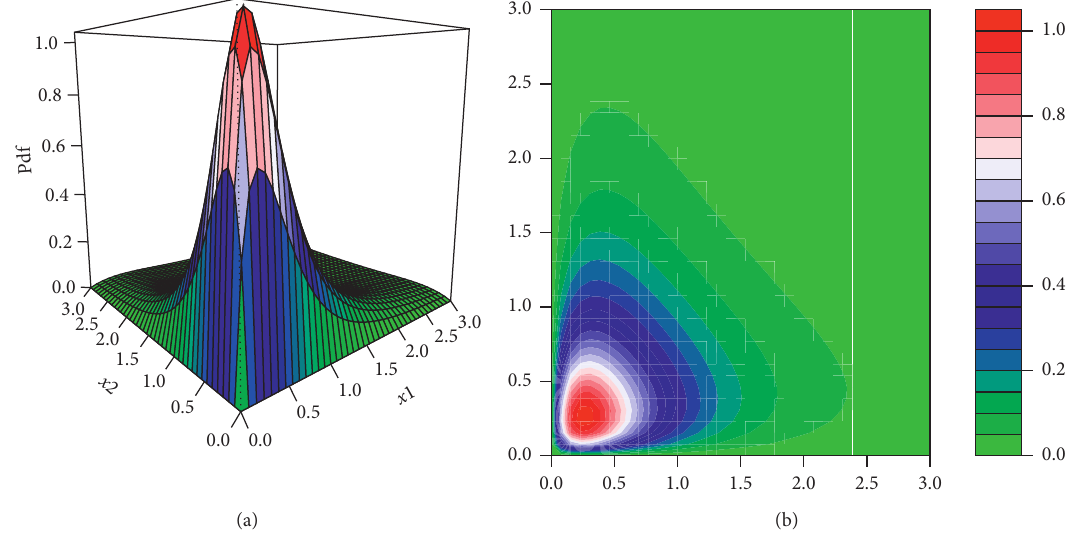
� α � 3 , c � c � 1 , σ � σ � 0 . 5, and ρ � − 0 . 5 and ρ � − 1 2 1 2 1 2